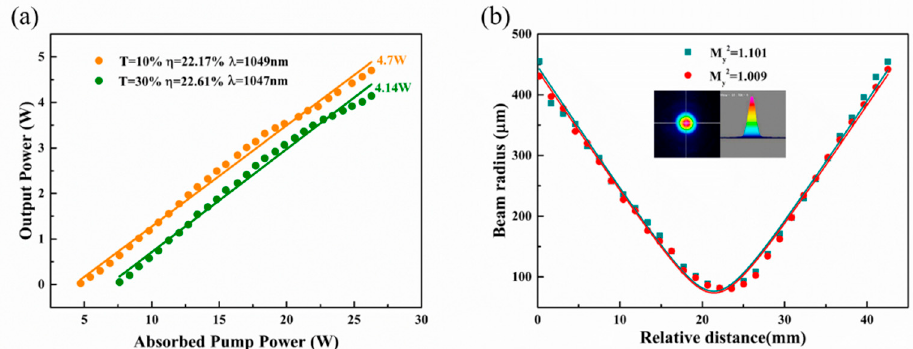
Figure 10. The continuous-wave (CW) laser performance ( a ) and the quality of the laser beam ( b ) at the maximum power output of the 1 mm diameter Yb:LuAG SCF.